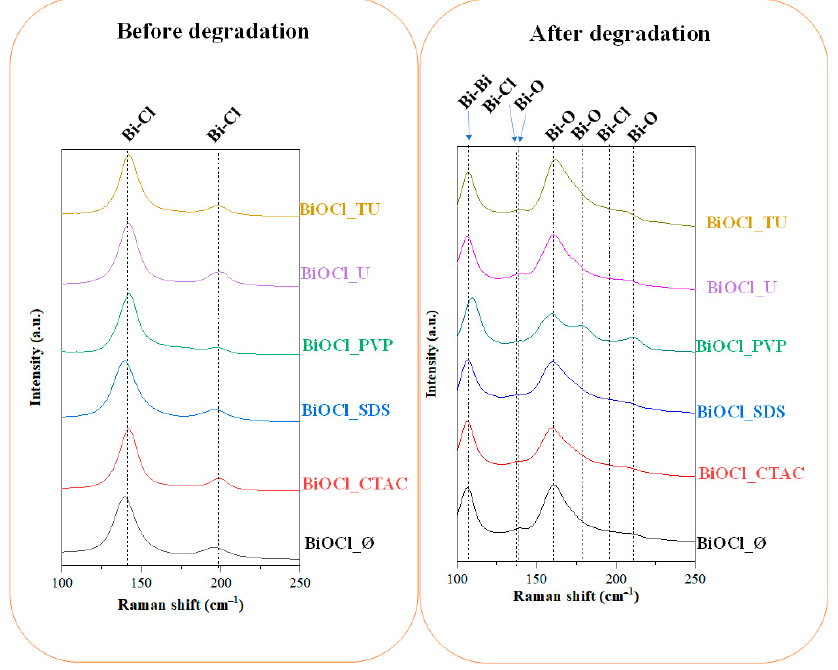
Figure 6. The Raman spectra of the obtained BiOCl semiconductors synthetized with different additives.